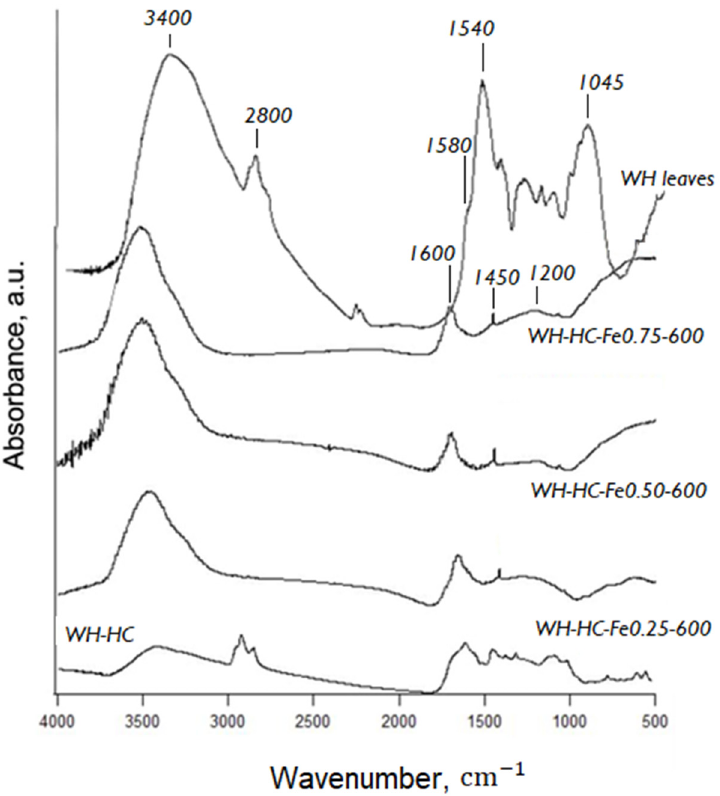
Figure 7. FT-IR spectra of WH, WH-HC, HCs, and HCs prepared by Fe-assisted HTC.